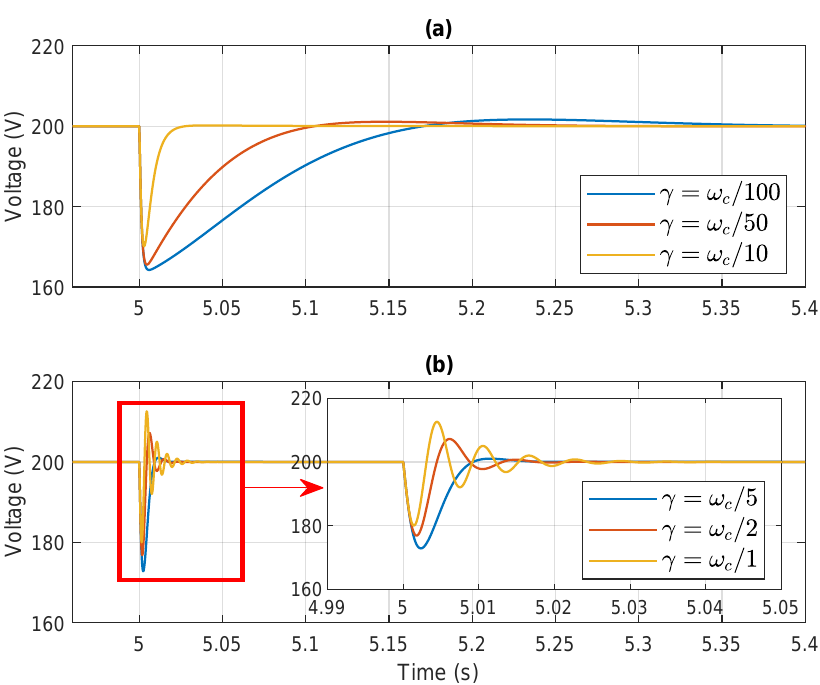
Figure 17. Simulation results showing the output voltage behavior for different values of γ . ( a ) Values of γ that result in slower dynamics, ( b ) values of γ that result in faster dynamics.